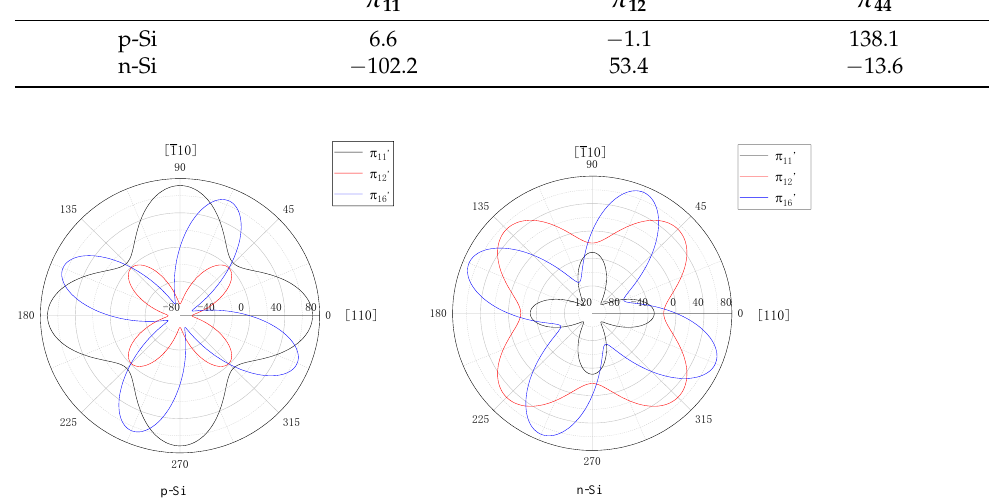
Figure 2. The p-type and n-type piezoresistance coefficients vary with direction on the (100) plane, and the radial coordinate is the piezoresistive coefficient (10 − 11 /Pa). The circumferential scale is from 0 to 360 degrees. According to Equation (3), to maximize the relative resistivity, the p-type piezoresistance chooses the <110> crystal orientation arrangement, and the n-type piezoresistance chooses the <100> crystal orientation arrangement.